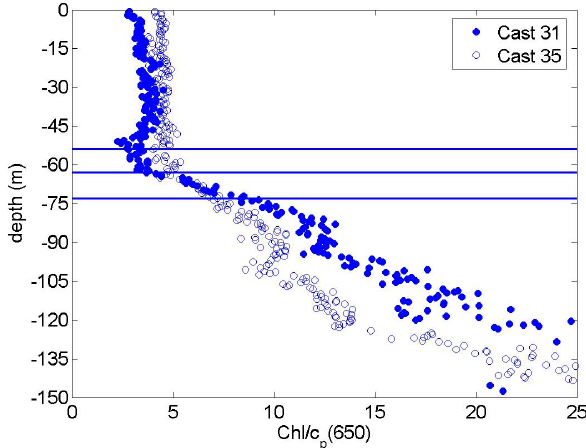
Fig. 7. Vertical profiles of normalized chlorophyll concentration and particle attenuation used to identify the four ecological regions observed at Opal ’s center. The two quantities were normalized by their maxima to scale them to a common range of values. The three black lines indicate respectively (shallower to deeper): depth of the upper mixed layer; top of the DCML; bottom of the DCML. They will be also used in Figs. 8, 10 and 11 to provide better evidence of the sensitivity of the different optical parameters to the observed changes in particle size and composition.